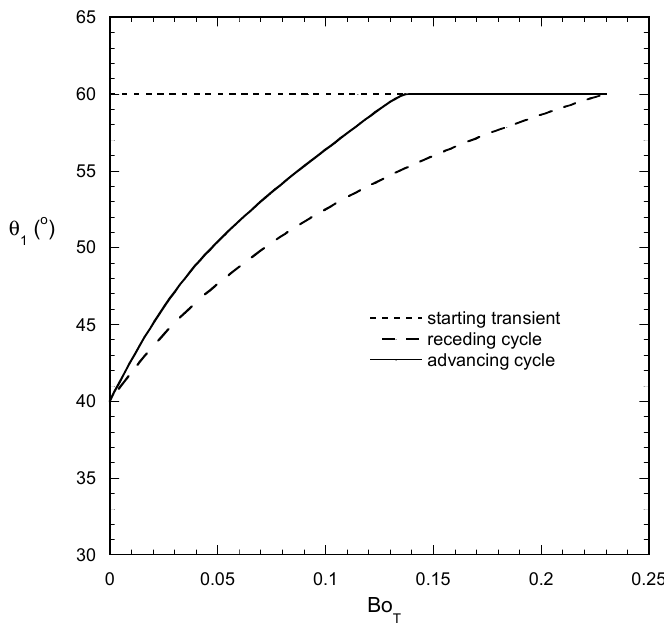
Figure 4. Evolution of droplet front angle θ 1 with Bo T for Bo N = 12 Bo T and periodic forcing (V A = 5 mm 2 , θ a = 60°, θ r = 40°, θ ο = 60°).